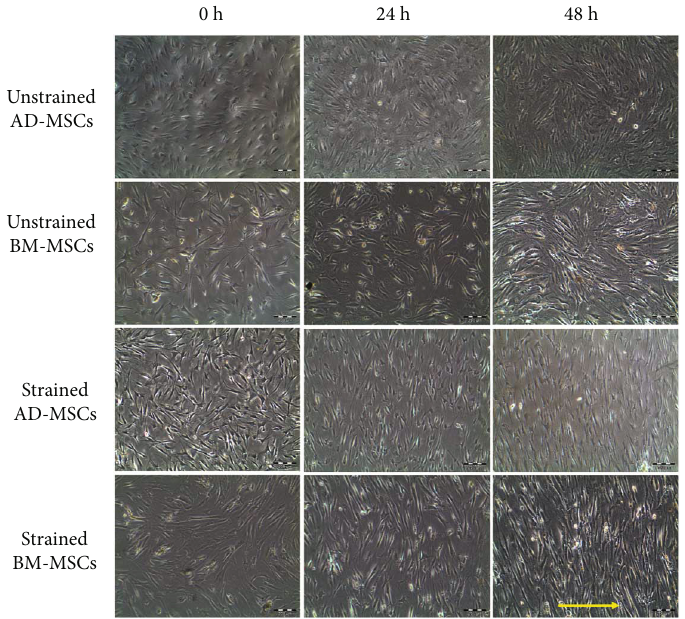
Figure 4: E ff ects of cyclic tensile loading on the morphology and orientation of both AD-MSCs and BM-MSCs. The strained cells presented an orientation perpendicular to the strain axis. The substrate was stretched in the direction of the yellow arrow.